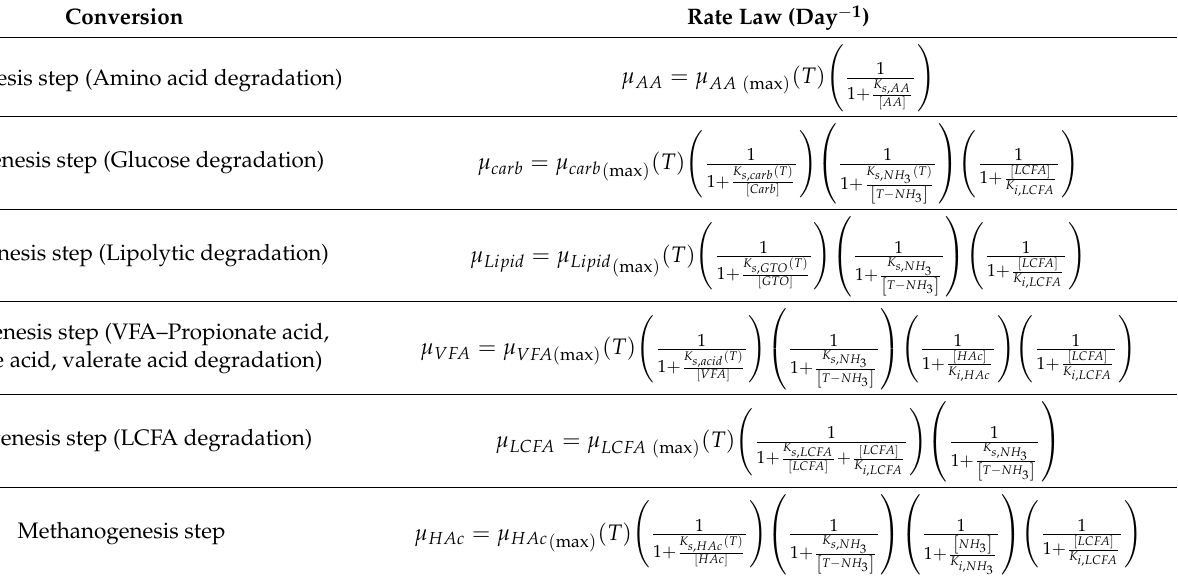
Table 1. Rate law expressions for the AD steps